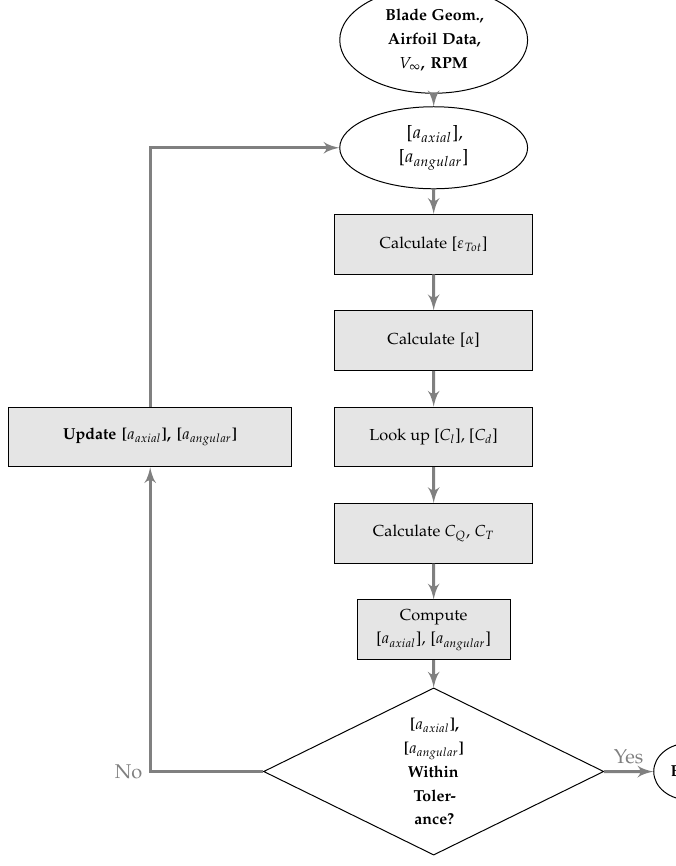
Figure 4. BEMT solution